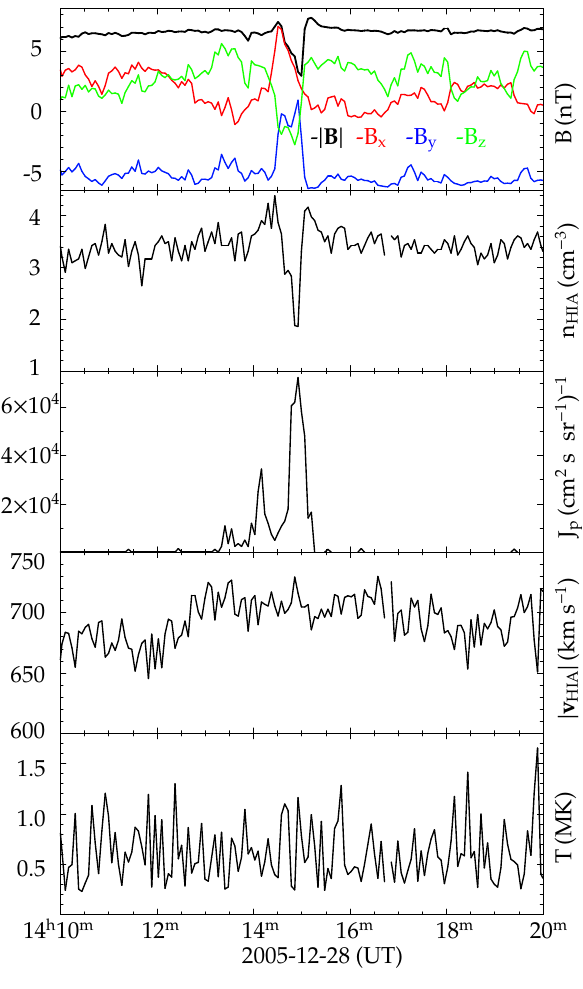
Fig. 1. Stacked time series traces giving an overview of the fore- shock cavity observed by Cluster on 2005-12-28 14:15:00 when the spacecraft were at (8.2, 16.1 -6.0)R E GSE. All parameters were measured by Cluster 3. The top panel shows the magnitude of the magnetic field and its components in GSE coordinates. The second panel shows the density of the thermal ion population from CIS mo- ments. The third panel shows the flux of energetic ( ≥ 35keV e − 1 ) ions measured by the RAPID instrument. The bottom two panels show the bulk flow speed and temperature of the ions measured by CIS. These signatures are typical of foreshock cavities with corre- lated dropouts in field strength and density lasting 50 seconds, as- sociated with enhanced suprathermal fluxes. The central field and density both drop to 0.59 of their exterior values. The pre- and post-event fields make an angle of 12 ◦ , the event has not formed on a significant solar wind discontinuity. This, along with the lack of significant changes in ion velocity and temperature, mark this event as a foreshock cavity rather than a HFA.